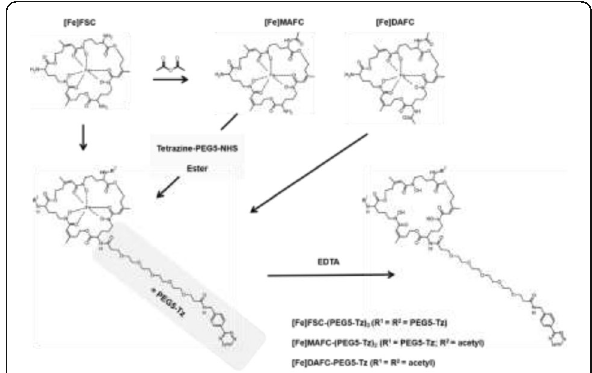
Fig. 1 (abstract OP02). Scheme: Synthetical pathway of tetrazine modified FSC-based pretargeting